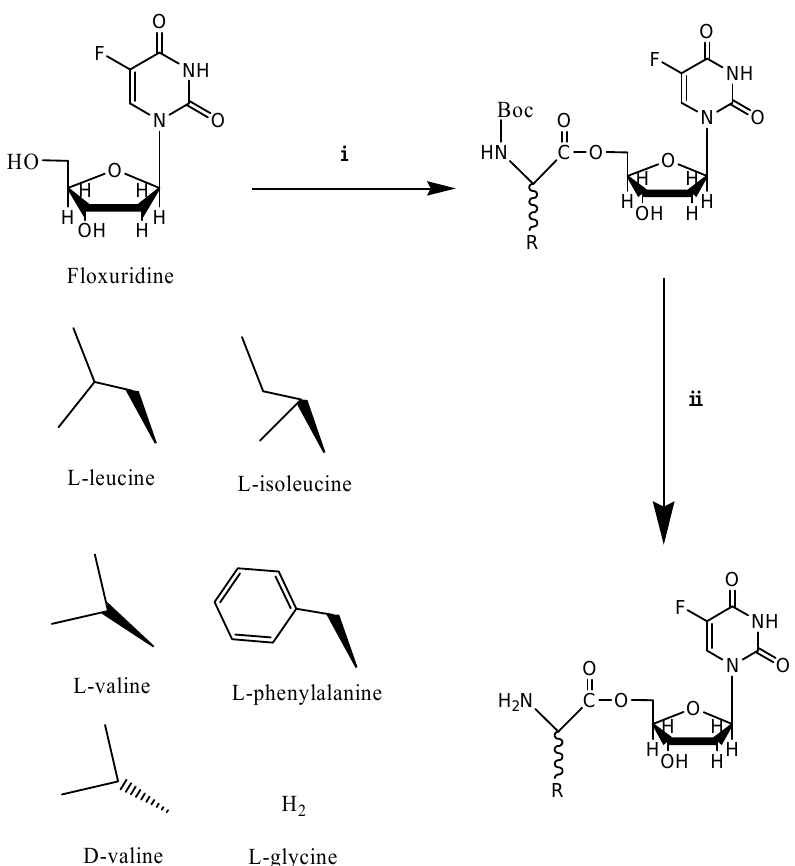
Scheme 1 . Synthesis of amino acid ester prodrugs of